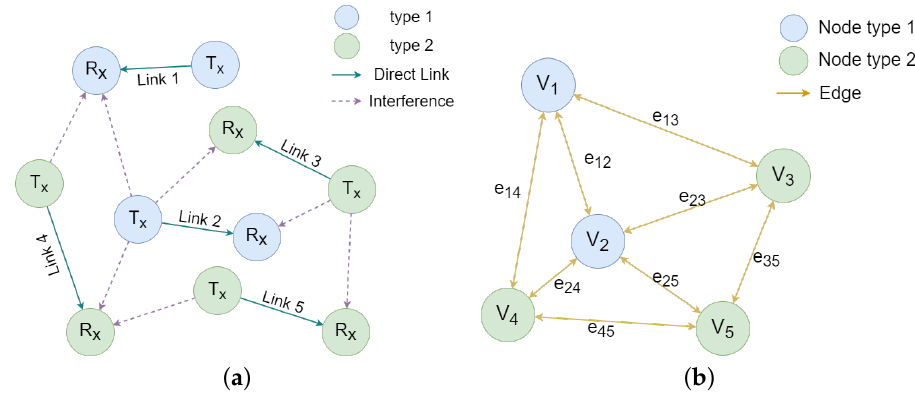
Figure 2. Constructing graph for Ad Hoc network with 2 state types. ( a ) An example of Ad Hoc network with 2 state types. ( b ) A graph describing the Ad Hoc